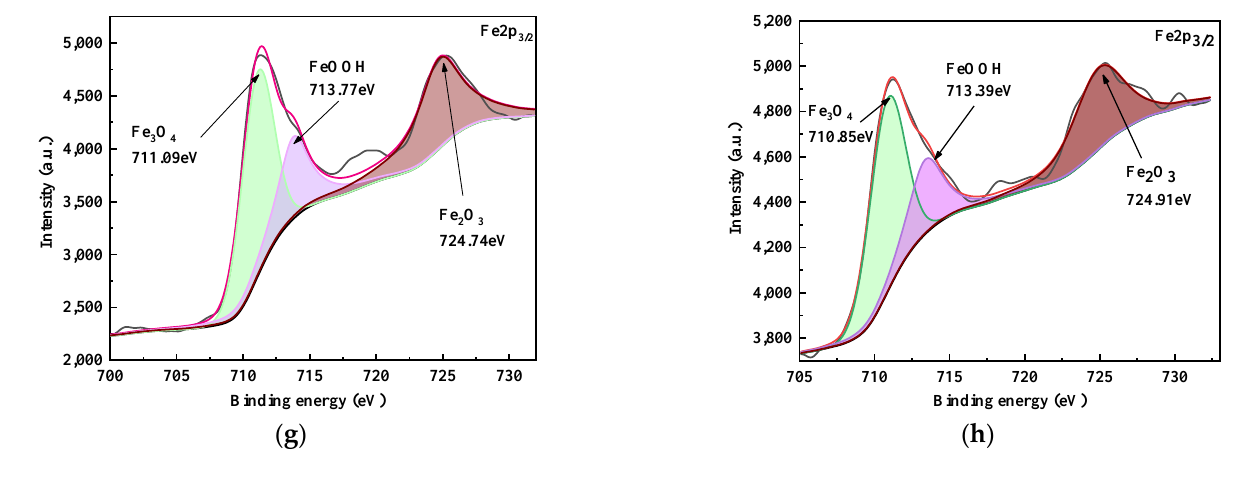
Figure 8. The XPS spectrum of different elements of the corrosion products layer at different times under gas – liquid two-phase bubble flow conditions: ( a ) the total binding energy range at 2 h, ( b ) the total binding energy range at 7 h, ( c ) C 1s at 2 h, ( d ) C 1s at 7 h, ( e ) O 1s at 2 h, ( f ) O 1s at 7 h, ( g ) Fe 2p3/2 at 2 h, ( h ) Fe 2p3/2 at 7 h.